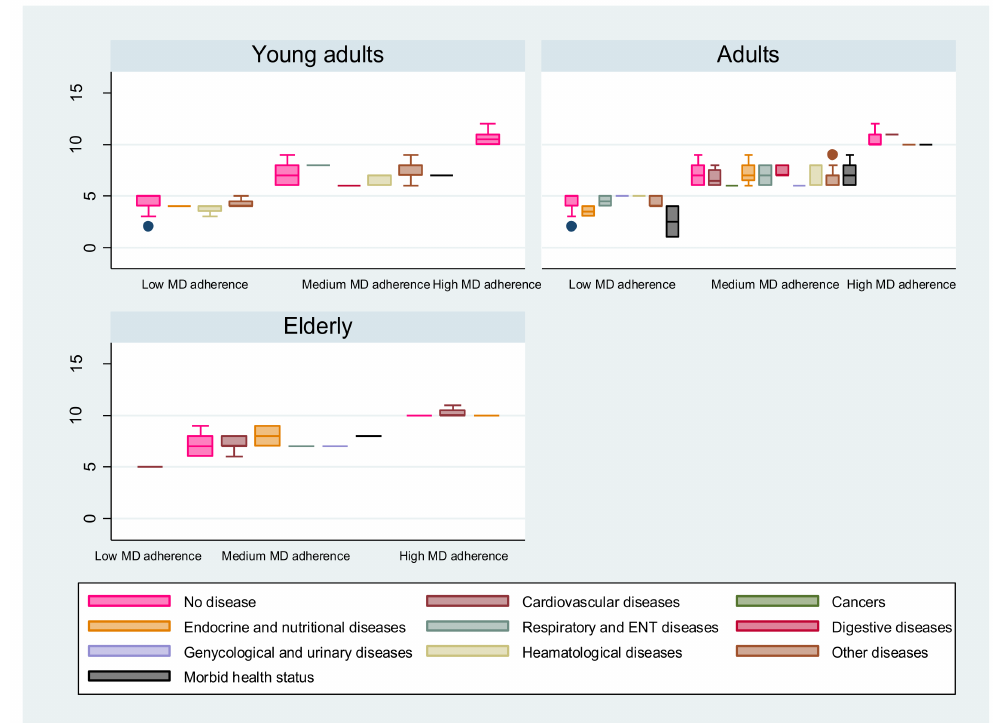
Figure 3. Impact of MD adherence on health status for the three MD-adherence profiles. Distribution of MEDAS score over MD adherence by age category and chronic diseases declared by participants. Kruskal–Wallis tests showed a significant difference in MEDAS score related to health status con- sidered ( p = 0.047). For all age categories, healthy participants recorded the highest MEDAS scores. Adults with morbid health status with multiple chronic diseases recorded the lowest MEDAS